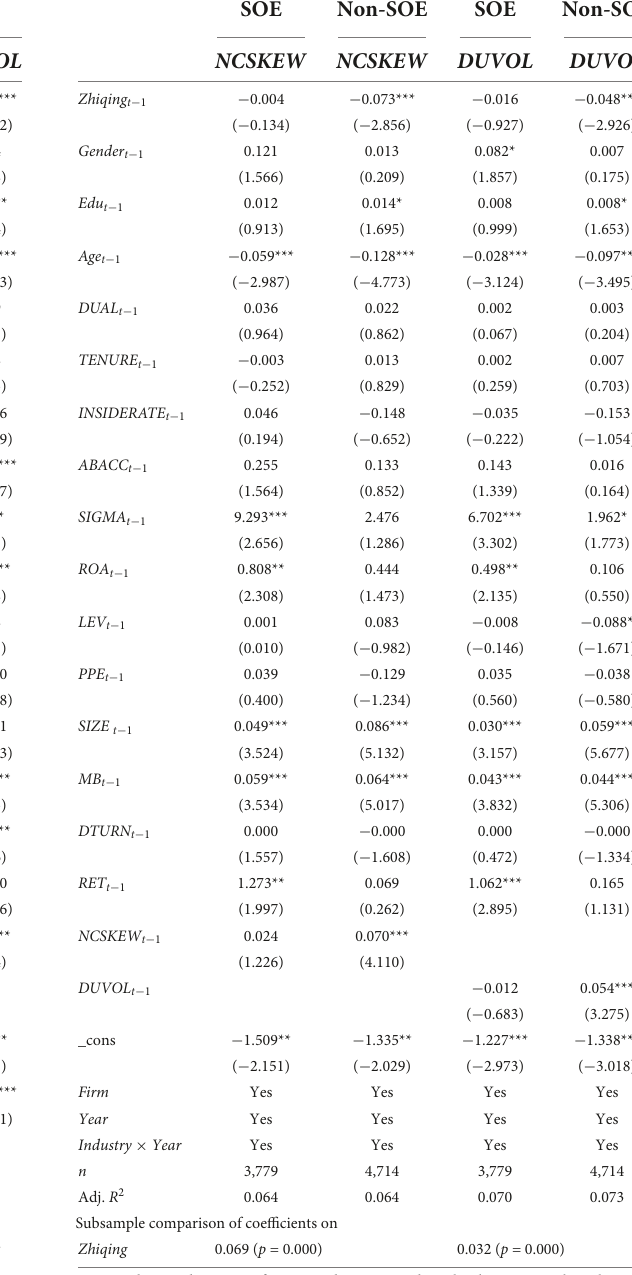
TABLE 5 Full sample regression results. TABLE 6 Regression results by business